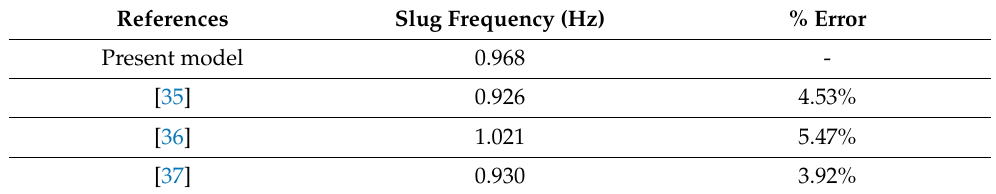
Table 3. Comparison of slug frequency between simulation results and experimental